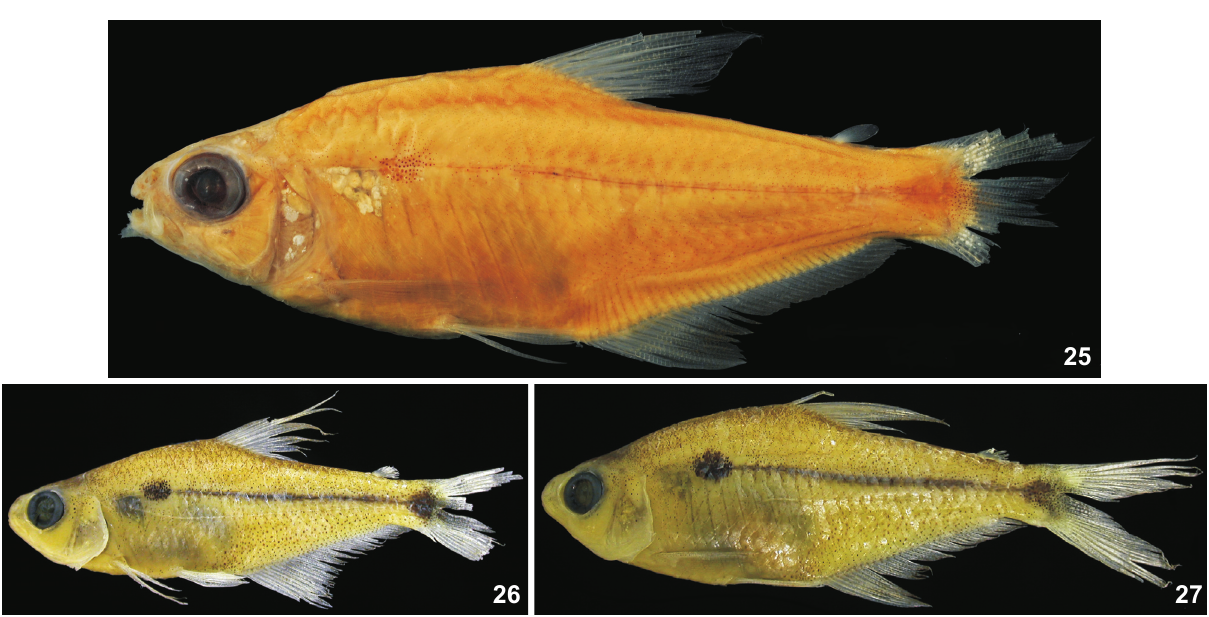
Figuras 25-27. Phenacogaster calverti : (25) ANSP 69606, holótipo, 38,8 mm CP, Fortaleza, Ceará. Foto Kyle Luckenbill; (26) MCP 30683, macho, 30,8 mm CP e (27) MCP 30683, fêmea, 36,4 mm CP, Rio Piranhas, Paraíba. Comparar a forma da nadadeira anal de macho e